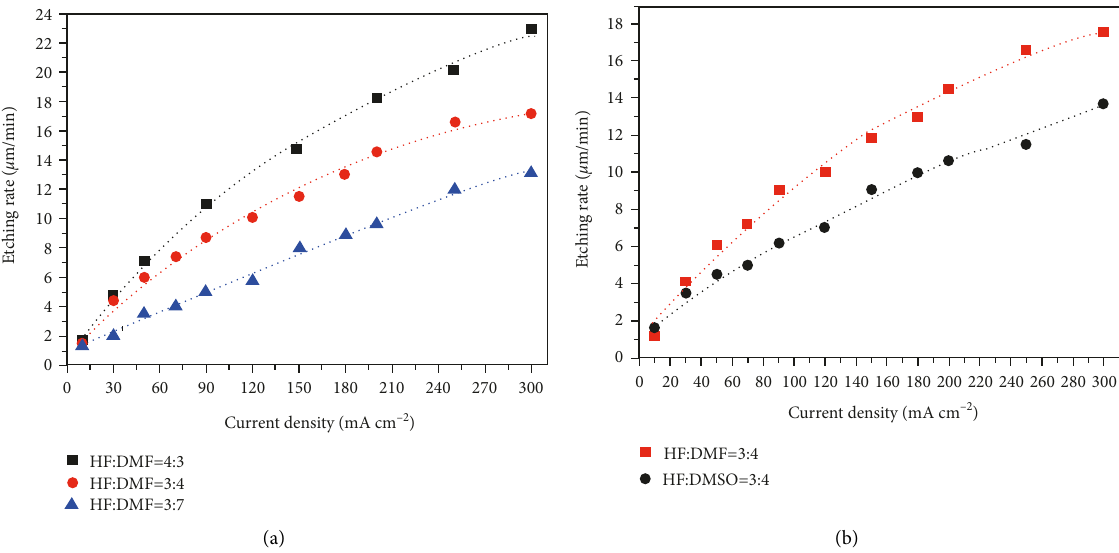
Figure 9: Macropore etching rate dependence on the current density in the electrolytes containing: (a) (blue triangle) HF:DMF � 3: 7, (red spot) HF :DMF � 3:4, (black square) HF: DMF � 4:3; (b) [HF] � 43 vol% and different organic solvents: (red square) DMF; (black